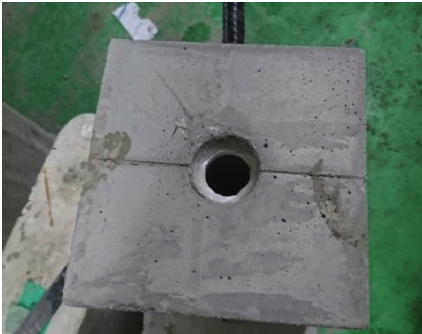
Figure 15: Styrofoam stopper for inserting rock bolt and injecting grout.